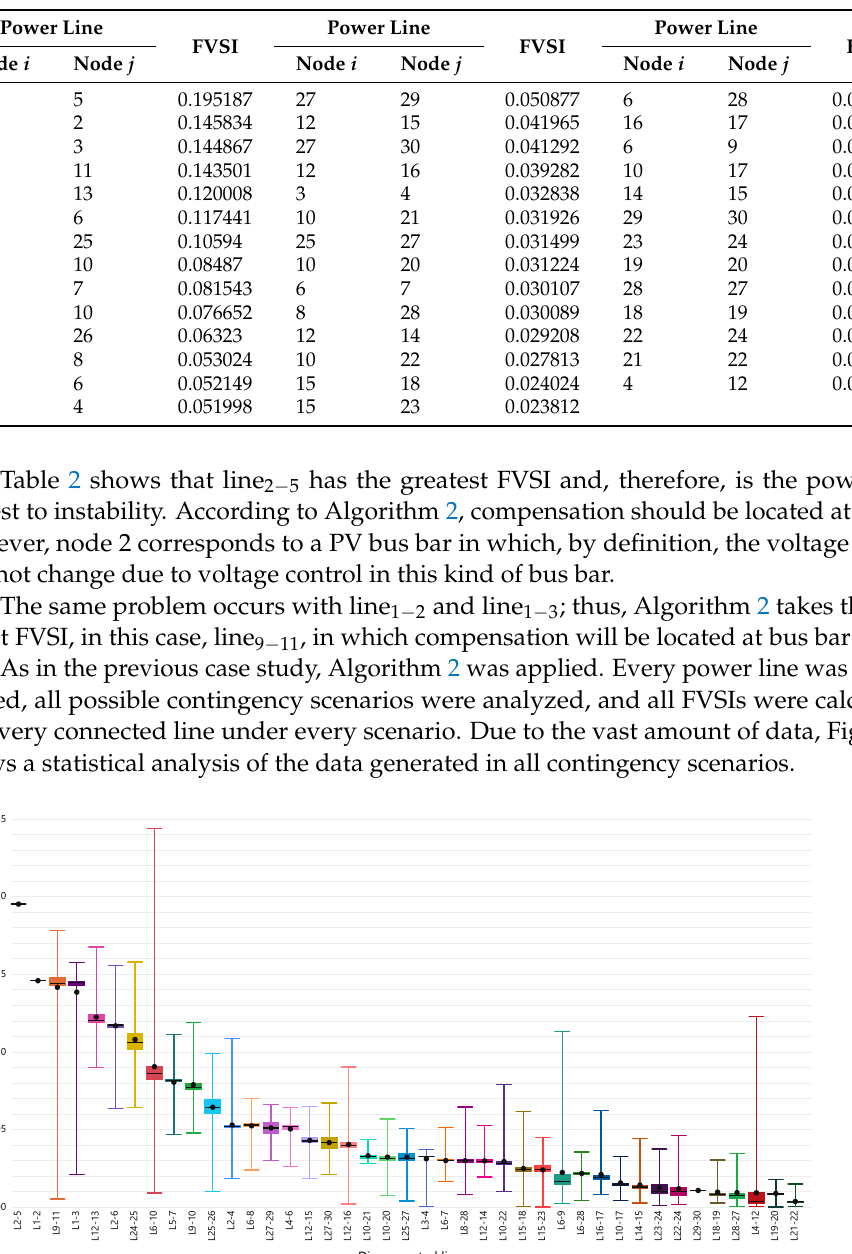
line 2 − 5 , line 1 − 2 , line 1 − 3 , or line 9 − 11 is